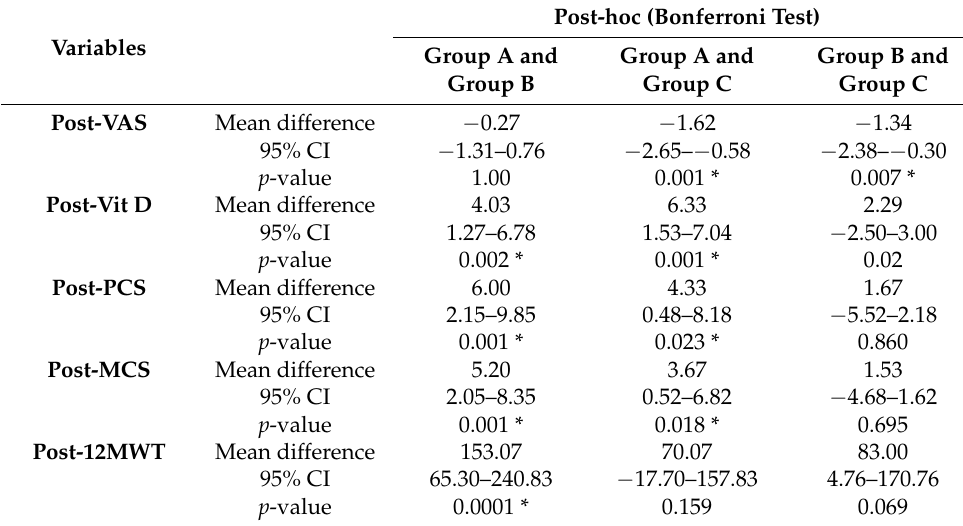
Table 3. Post-hoc test between pairwise of groups A, B, and